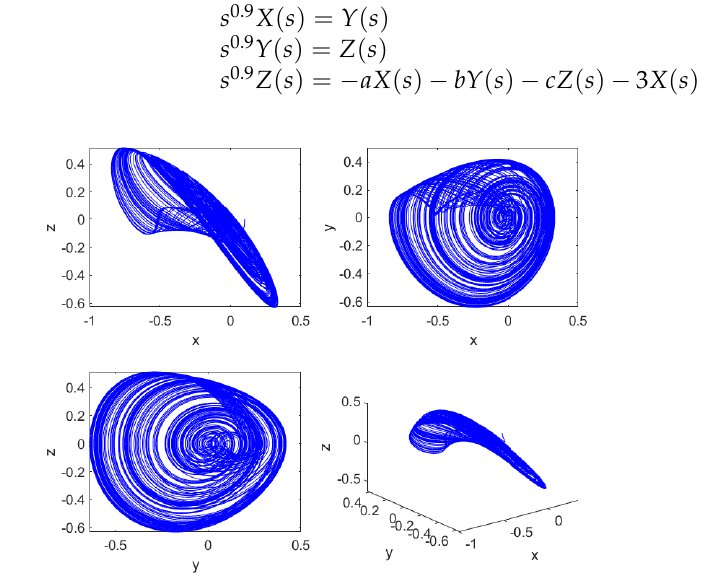
Figure 1. Portraits of the chaotic attractors of FOCO 1 given in (4). Each plot shows the attractor among two or three state variables x , y , z